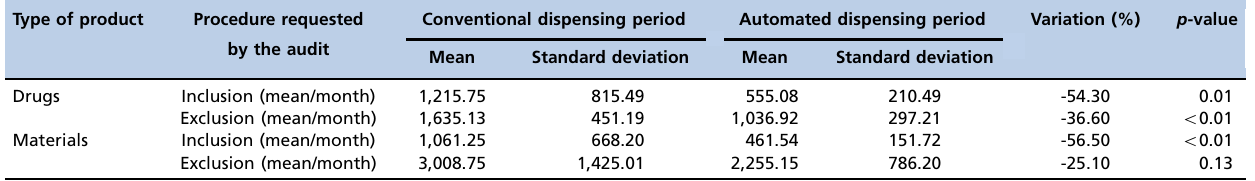
Table 2 - Audit adjustments to material and medication invoicing in the Advanced Heart Failure Unit of Hospital Sı´rio-Libaneˆs before and after implementing the automated medication dispensing system. 2013-2014. Sa˜o Paulo, Brazil. Type of product